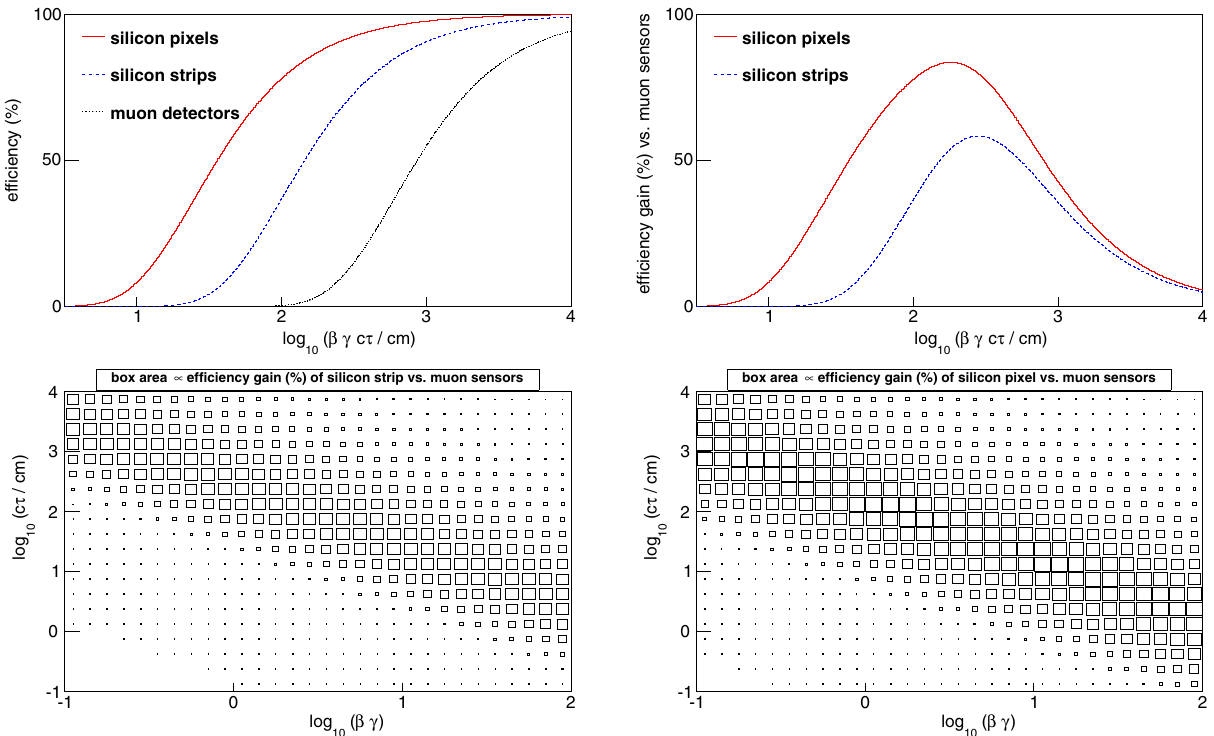
25 cm), Figure 1. (top left) The probability of a metastable particle to traverse the silicon pixel sensors ( r max = 1 m), and the muon sensors ( r typical 6 m), before decaying. (top right) The silicon strip sensors ( r max = = incremental gain in triggering efficiency by deploying our method on the silicon tracking sensors, given existing muon sensor triggers. The incremental gain is defined as the difference between the pixel or strip sensor curve and the muon sensor curve in the top-left figure. Note that the muon sensors are located at radii between 4.5 m and 7 m (10 m) in CMS (ATLAS). (bottom) The incremental gain in triggering efficiency by using the silicon p / m ) and c τ . The probability in each bin is strip (left) and pixel (right) sensors, in the phase space of βγ ( = proportional to the box area, on a scale of